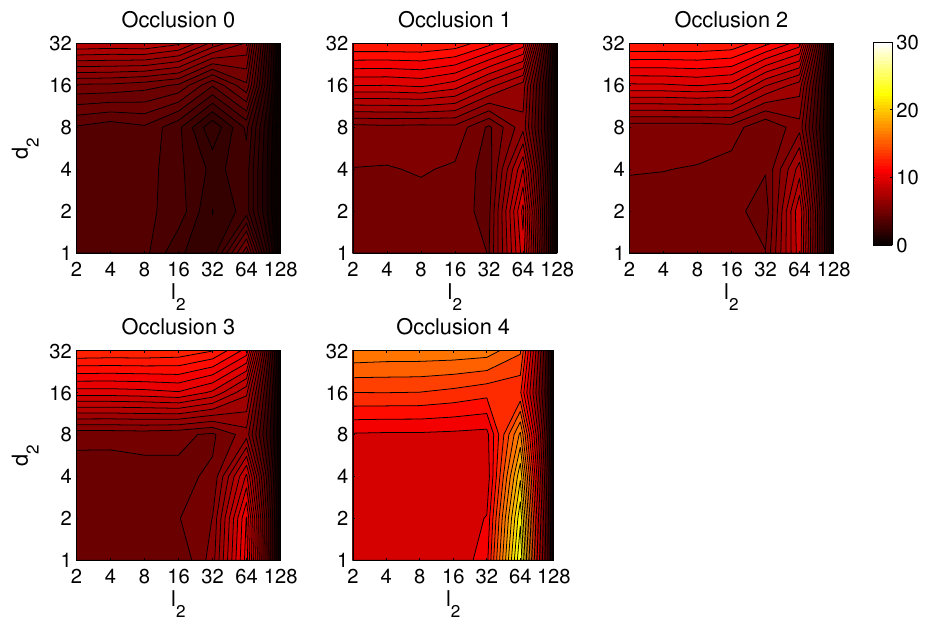
Figure 36. Gist orientation estimation in the presence of occlusion. Average orientation error